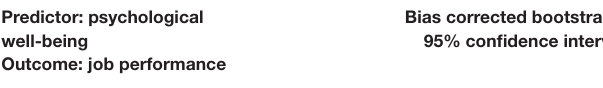
TABLE 4 | The bootstrapping results of mediation. Predictor: psychological well-being Outcome: job performance